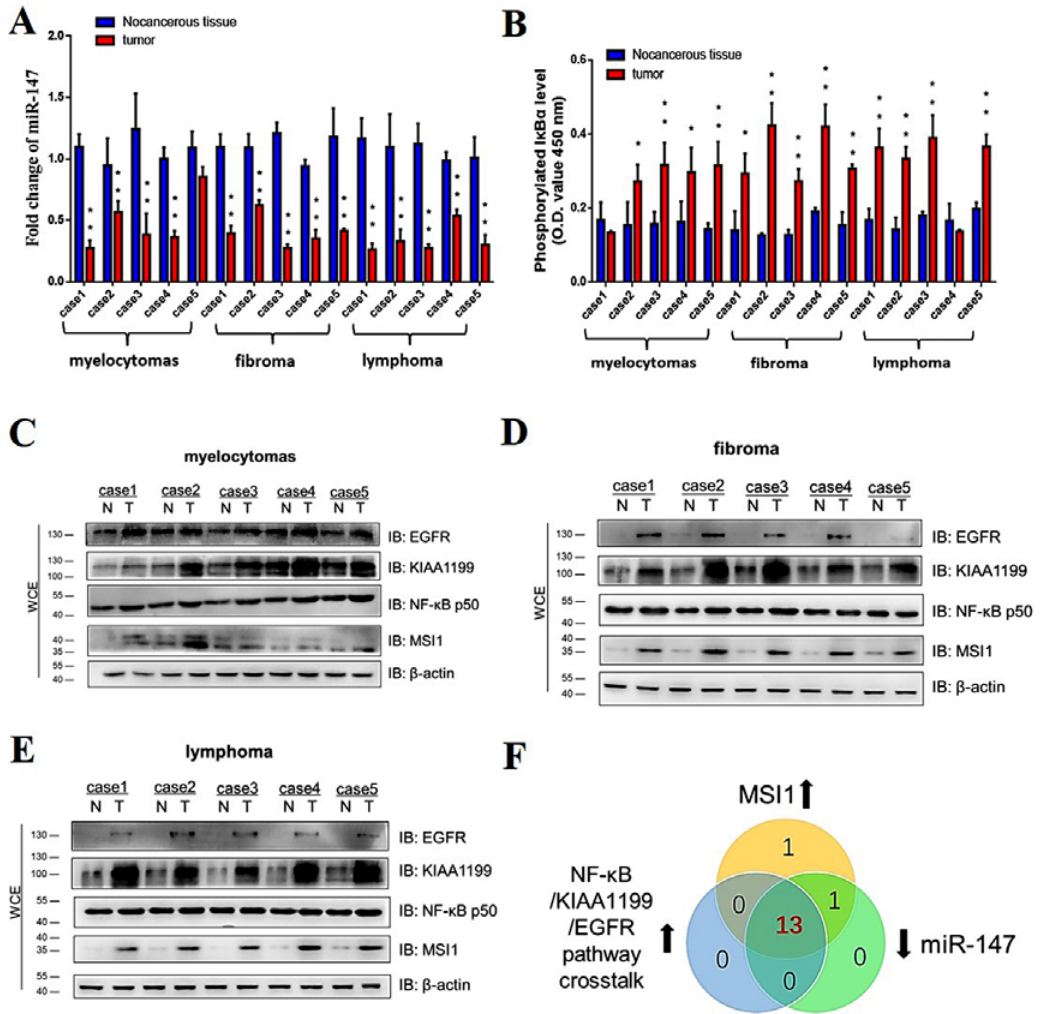
Figure 9. miR-147 was downregulated in ALV-J and REV coinfection-induced tumors and was negatively correlated with MSI1 and NF- κ B/KIAA1199/EGFR pathway crosstalk. ( A ) Expression levels of miR-147 in 14 of 15 tumors were lower than those of corresponding non-cancerous tissues, as detected using qPCR. Data are presented as mean ± SEM for n = 3, with each experiment being performed in triplicate. ( B ) Phosphorylated I κ B α expression levels in 13 of 15 tumors were elevated when compared to corresponding non-cancerous tissues, as detected using an NF- κ B P-I κ B α ELISA kit. Data are presented as mean ± SEM for n = 3, with each experiment being performed in triplicate. ( C ) Expression levels of EGFR, KIAA1199, NF- κ B p50, and MSI1 in myelocytomas were detected using WB with anti-EGFR, anti-KIAA1199, anti-NF- κ B p50, and anti-MSI antibodies, respectively. ( D ) Expression levels of EGFR, KIAA1199, NF- κ B p50, and MSI1 in fibromas were detected using WB with anti-EGFR, anti-KIAA1199, anti-NF- κ B p50, and anti-MSI antibodies, respectively. ( E ) Expres- sion levels of EGFR, KIAA1199, NF- κ B p50, and MSI1 in lymphomas were detected using WB with anti-EGFR, anti-KIAA1199, anti-NF- κ B p50, and anti-MSI antibodies, respectively. ( F ) Comparisons of MIS1 elevation, miR-147 elevation, and NF- κ B/KIAA1199/EGFR pathway crosstalk elevation in tu- mors. Central overlapping region represents all cases of MIS1, miR-147, and NF- κ B/KIAA1199/EGFR pathway crosstalk elevations. ** p ≤ 0.01 determined using Student (cid:48) s t -test versus the Neg. Ctrl. group. * p ≤ 0.05 determined using Student (cid:48) s t -test versus the Neg. Ctrl.